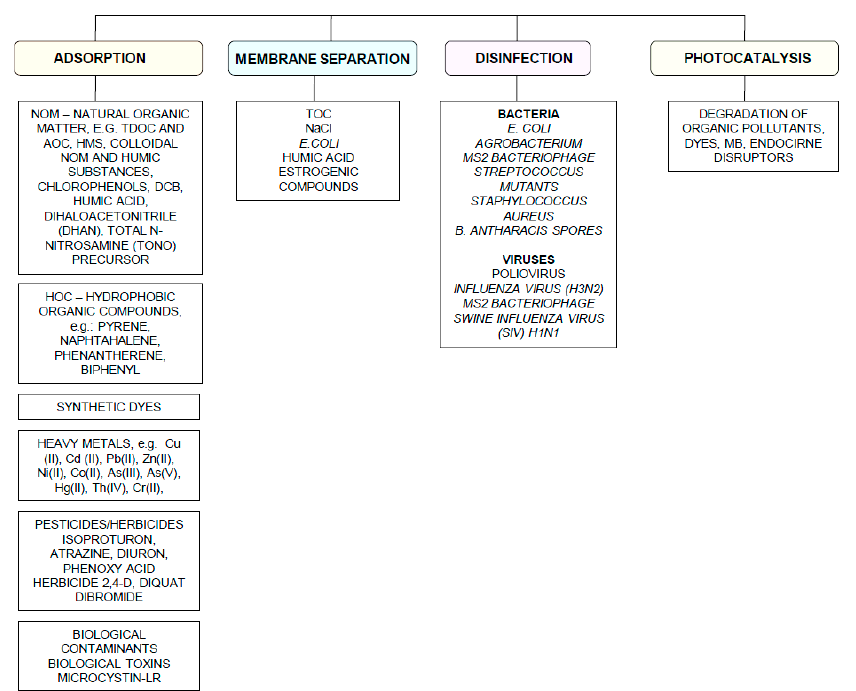
Figure 1. The potential applications of carbonaceous nanomaterials in wastewater treatment.